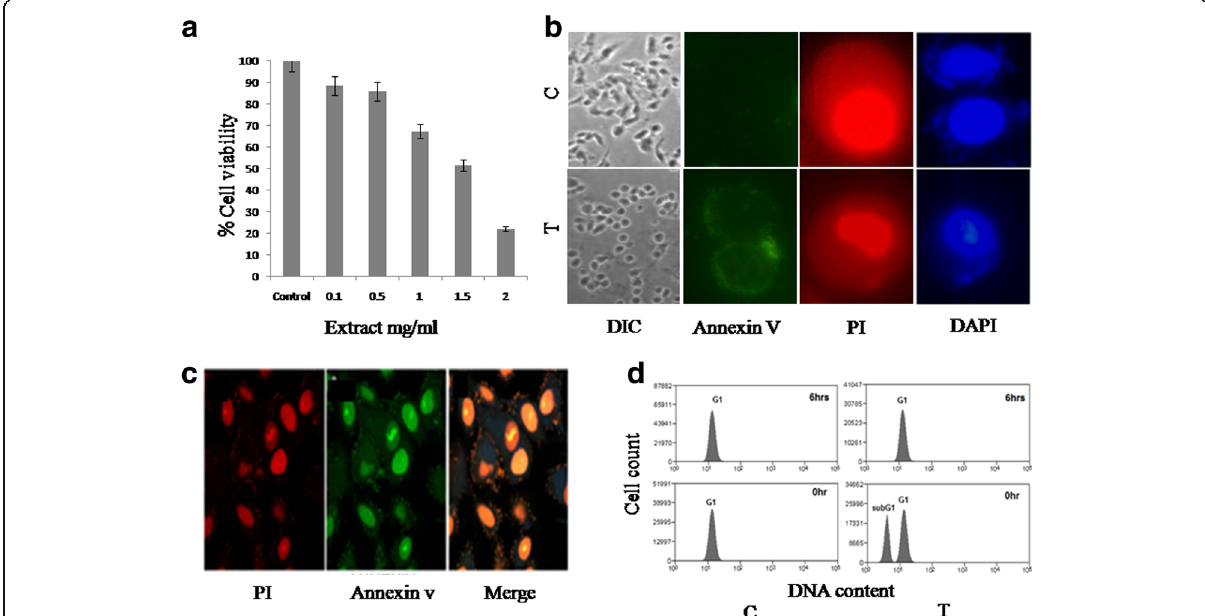
Fig. 3 In vitro analysis of anticancer activity in A549 cells. a Cytotoxicity analysis in A549 cells identifies IC50 as1.5 mg/ml of GAE. b Fluorescent imaging with Annexin, Propidium iodide and DAPI revealed the translocation of Phosphatidyl serine to the cell membrane and nuclear fragmentation in GAE treated cells. c Confocal imaging of GAE treated cells showing nuclear fragmentation. d FACS analysis of Apoptosis by DAPI staining shows the emergence of apoptotic peak after 6 h of GAE treatment. All experiments were done in triplicate. The values represent Mean ± SD. C-control,